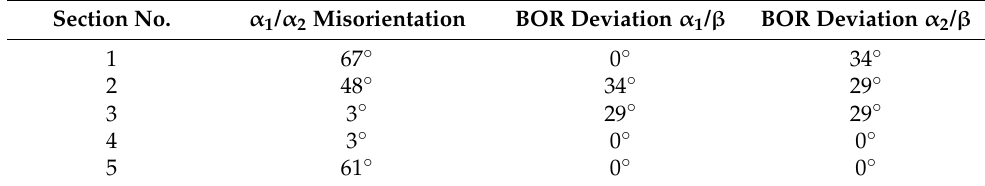
Figure 6. Phase map for the solution-treated and FC Ti-6Al-4V showing β -phase precipitation variants; α -phase—red; β -phase—blue; green color characterizes the deviation from BOR at angles > 5°. Table 1. Grain boundaries misorientations in Figure 6.